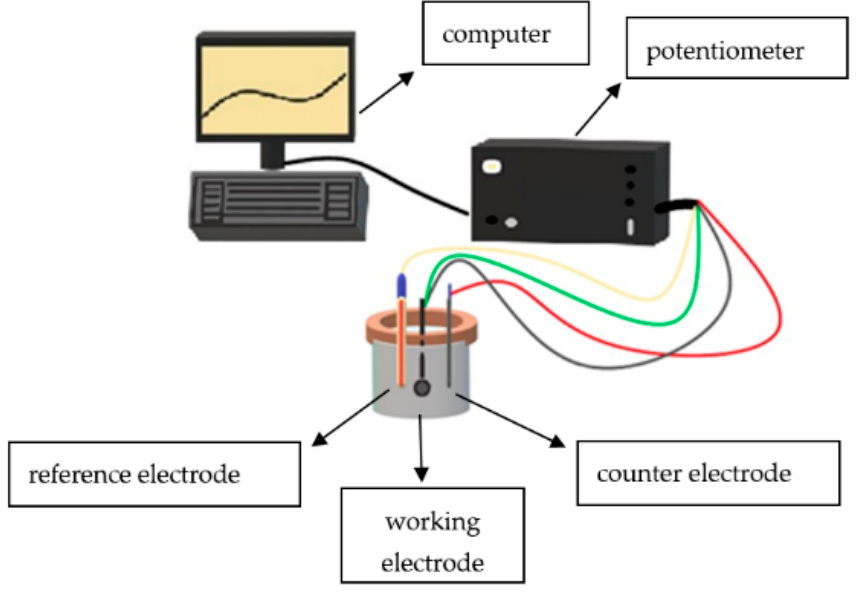
Figure 1. Apparatus for electrochemical measurements .